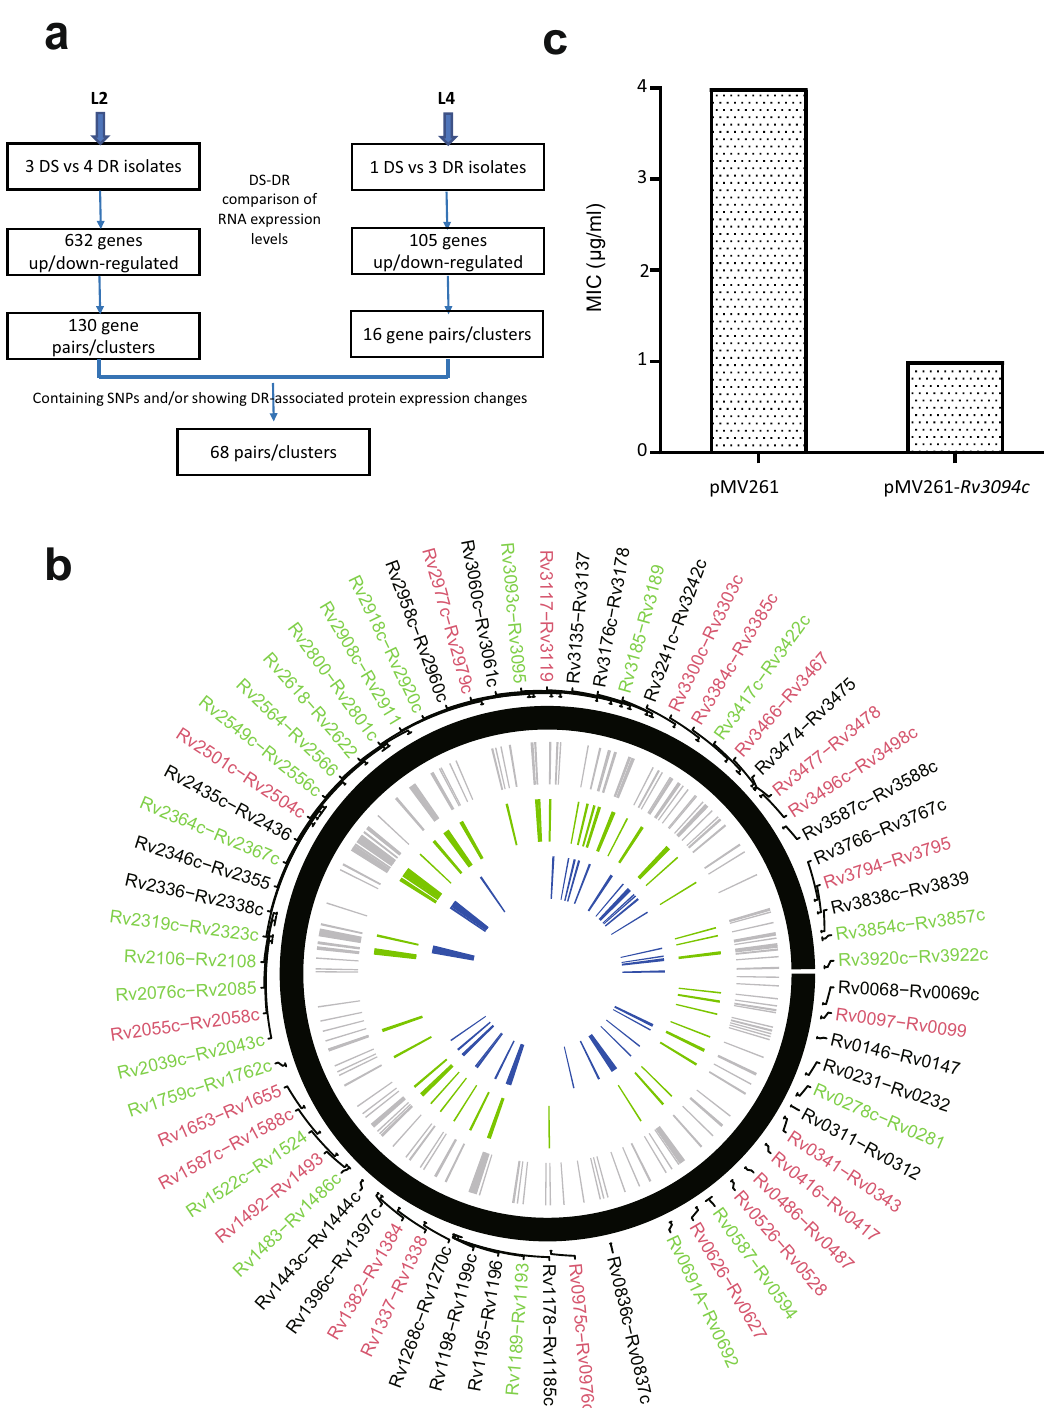
Fig. 3 Multi-omic analysis identi fi es 68 candidate drug resistance-associated gene pairs/clusters. a Flowchart of the analysis of transcriptomic/ genomic/proteomic data from the 11 isolates leading to the identi fi cation of drug resistance-associated gene pairs/clusters. b Distribution of candidate drug resistance-associated gene pairs/clusters showing multi-omic variation in the M. tuberculosis genome. Outermost circle: distribution of the 68 drug resistance-associated gene pairs/clusters in the M. tuberculosis genome (black: gene pair/cluster does not contain an operon; red: all genes in the pair/ cluster are in the same operon; green: some genes in the pair/cluster are in the same operon), the second circle (gray) shows the 144 gene pairs/clusters that show drug resistance-associated variation in RNA levels. The third circle (green) shows 48 gene pairs/clusters that had drug resistance-associated changes in protein expression and the innermost circle (blue) shows 38 genes pairs/clusters that contain candidate drug resistance-associated SNPs. Results were visualized using Circus 63 . c MIC analysis of an M. tuberculosis H37Ra strain overexpressing Rv3094c against ethionamide. Results presented are representative of three replicate